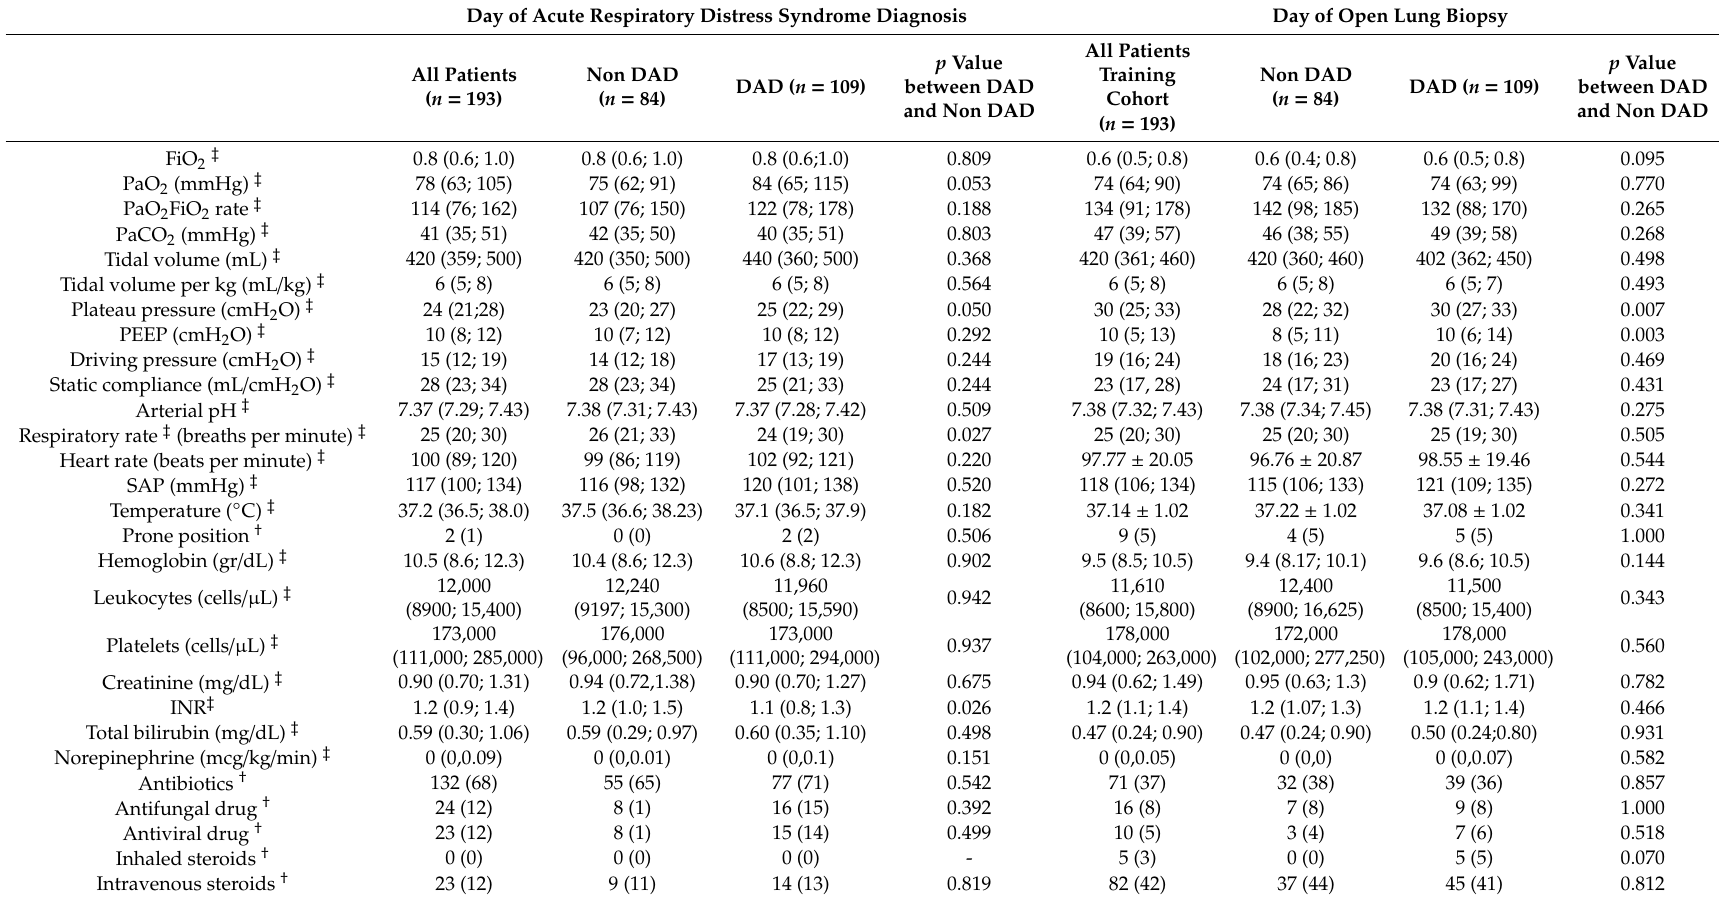
Table 4. Bivariate analysis for DAD on the day of ARDS and the day of